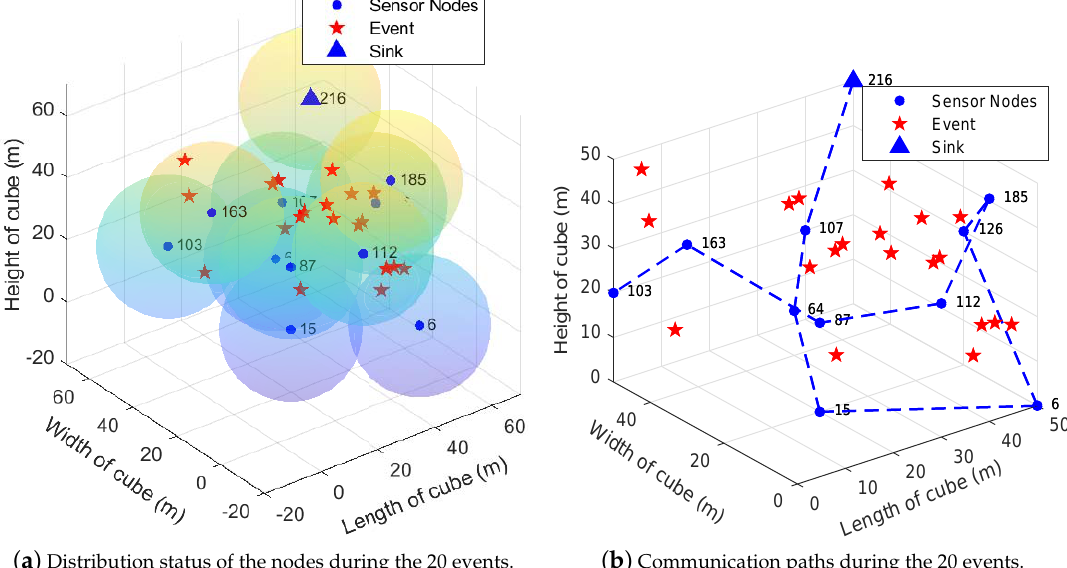
Figure 5. Experiment 2: 20 events that were randomly distributed (unit: